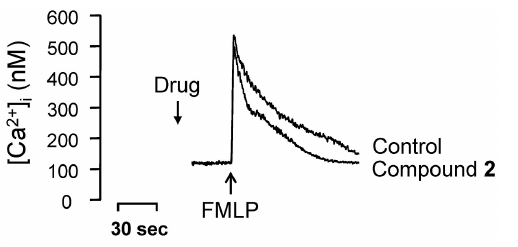
Figure S4 13 C and DEPT135 Spectra of Houpulin A (1). (TIFF) Figure S5 COSY Spectrum of Houpulin A (1). (TIFF) Figure S6 NOESY Spectrum of Houpulin A (1). (TIFF) Figure S7 HSQC Spectrum of Houpulin A (1). (TIFF) Figure S8 HMBC Spectrum of Houpulin A (1). (TIFF) Figure S9 IR Spectrum of Houpulin A (1). (TIFF) Figure S10 Mass Spectrum of Houpulin A (1). (TIFF) Figure S11 High Resolution Mass Spectrum of Houpu- lin A (1). (TIFF) Figure S12 1 H NMR Spectrum of Houpulin B (2). (TIFF) Figure S13 13 C and DEPT135 Spectra of Houpulin B (2). (TIFF) Figure S14 COSY Spectrum of Houpulin B (2). (TIFF) Figure S15 NOESY Spectrum of Houpulin B (2). (TIFF) Figure S16 HMQC Spectrum of Houpulin B (2). (TIFF) Figure S17 HMBC Spectrum of Houpulin B (2). (TIFF) Figure S18 IR Spectrum of Houpulin B (2). (TIFF) Figure S19 Mass Spectrum of Houpulin B (2). (TIFF) Figure S20 High Resolution Mass Spectrum of Houpu- lin B (2). (TIFF) Figure S21 1 H NMR Spectrum of Houpulin C (3). (TIFF) Figure S22 13 C and DEPT135 Spectra of Houpulin C (3). (TIFF) Figure S23 COSY Spectrum of Houpulin C (3). (TIFF) Figure S24 NOESY Spectrum of Houpulin C (3). (TIFF) Figure S25 HMQC Spectrum of Houpulin C (3). (TIFF) Figure S26 HMBC Spectrum of Houpulin C (3). (TIFF) Figure S27 IR Spectrum of Houpulin C (3). (TIFF) Figure S28 CD Spectrum of Houpulin C (3).